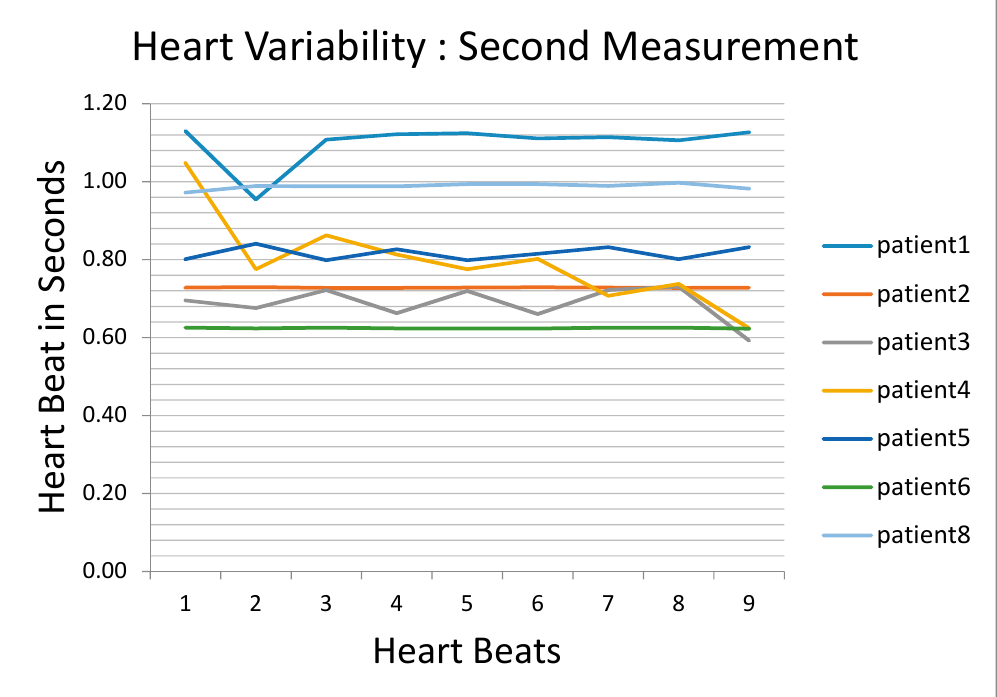
Figure 11. Heart rate variability results during the second measurement.